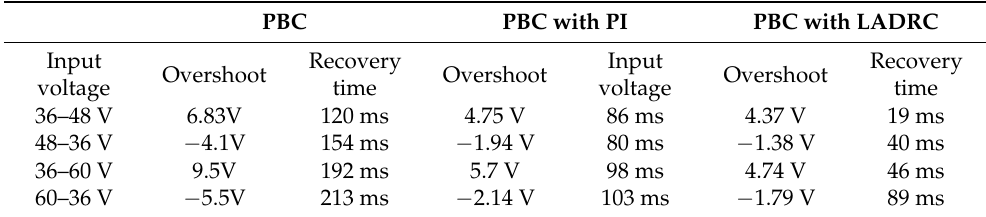
Table 3. The dynamic performance comparison during the v 2 step in step-up